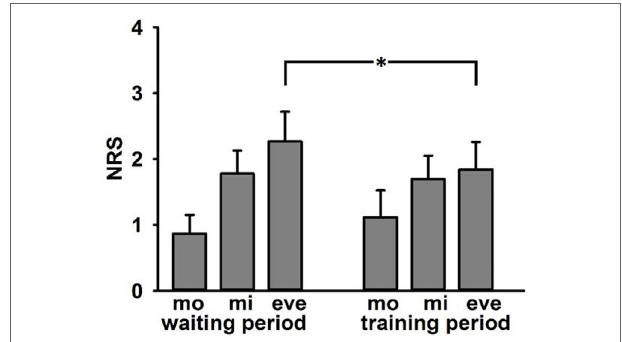
FigUre 4 | Adjusted mean values ( ± SE) of ratings of current phantom limb pain in numerical rating scale in pain diary (0 = no pain, 10 = strongest pain) separated for waiting and training period—mo, morning; mi, midday; and eve, evening. Asterisk indicates significant differences in post hoc